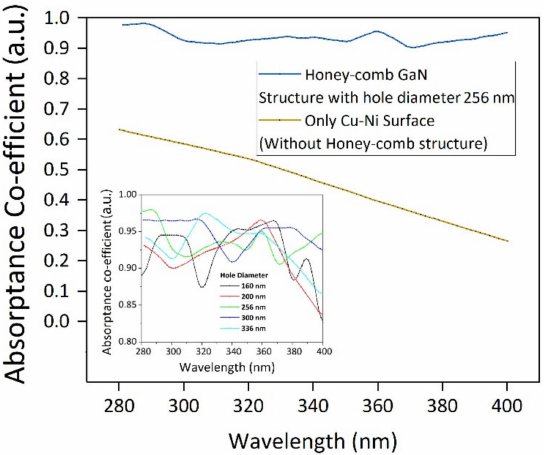
Figure 5. Graph presenting absorptance coefficient of Cu–Ni layer with and without honeycomb GaN structure against UV irradiance. The inset presents absorptance of UV at different hole diameters.